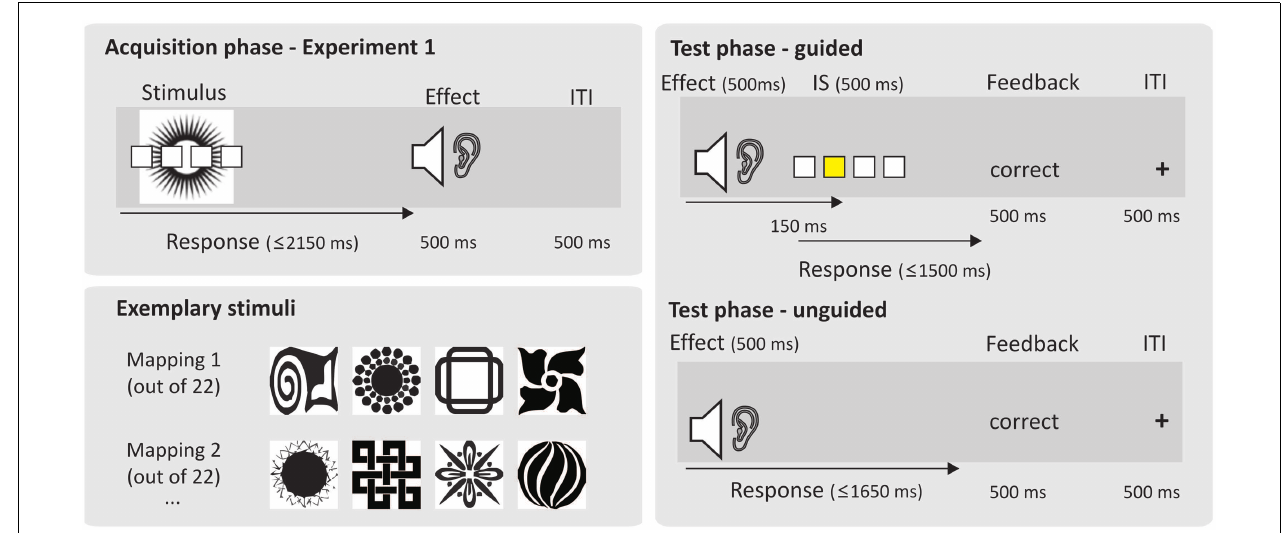
FIGURE 1 | Overview of the experimental procedures employed in Exp. 1. ITI refers to inter-trial interval. For Exp. 2A and Exp. 2B, this procedure was used in a modified form.